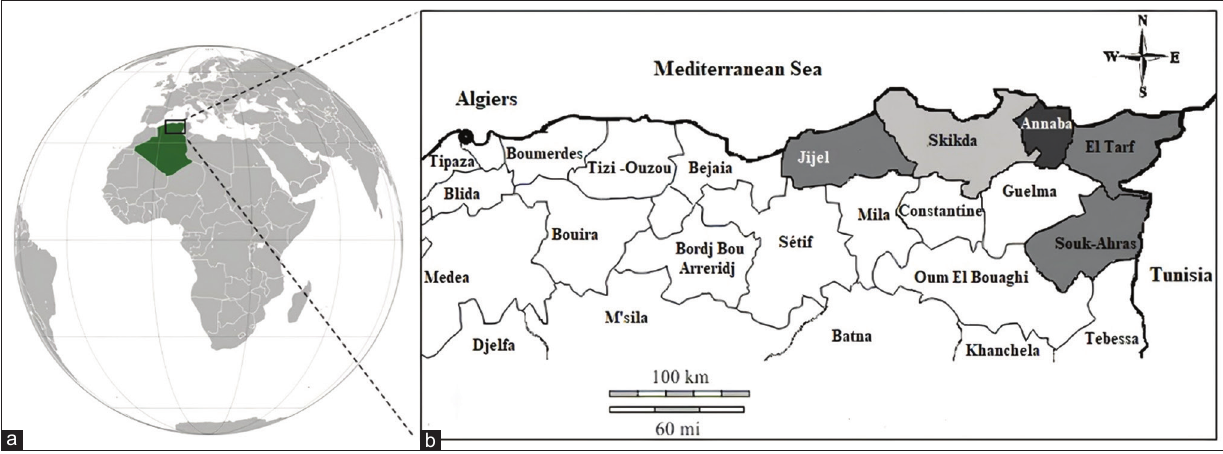
Figure-1: Map of the regions studied. (a) In Africa, Algeria. (b) Map of North-East Algeria; Sampled farms are indicated with gray areas [Source: modified from d-maps.com